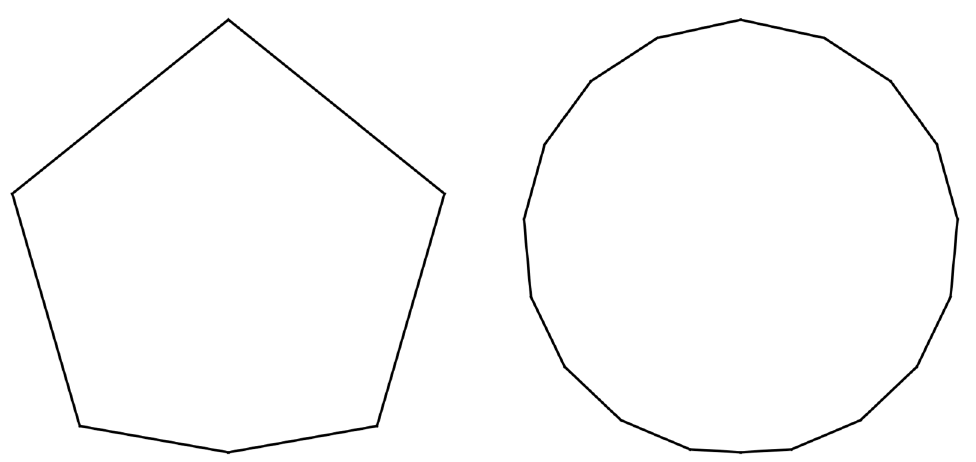
Figure 1. Our conjectured largest small polygons 𝐿𝑆𝑃(6) and 𝐿𝑆𝑃(18) .